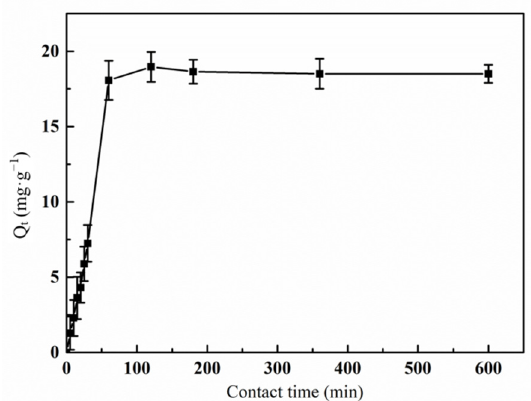
Figure 9. Effect of contact time on the adsorption of Hg(II) ions by graft polymer (pH value 5.5; initial concentration of Hg(II) ion 15 mg·L − 1 ; treatment temperature 45 °C).